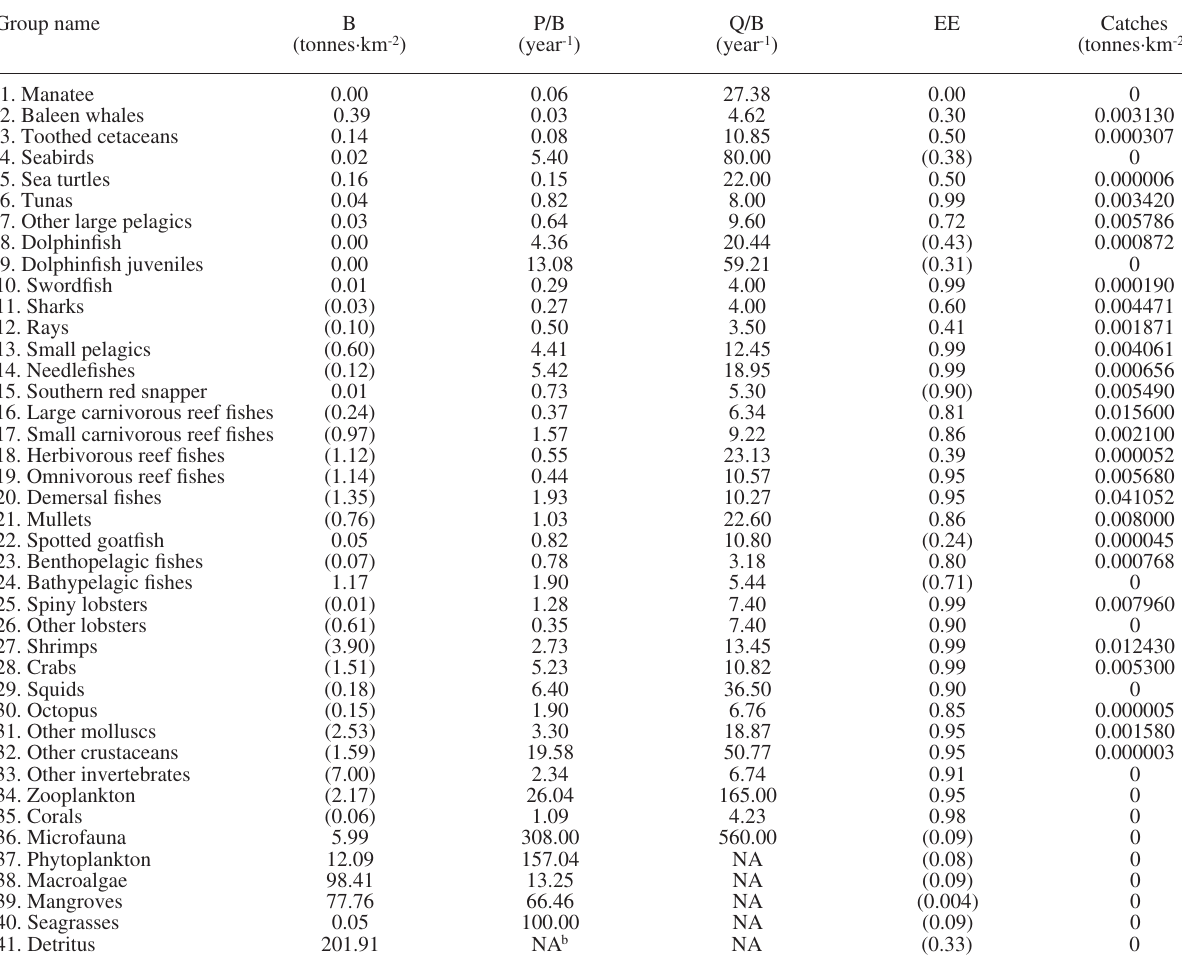
Table 1. – Basic input for the 1970s Ecopath with Ecosim model for the marine ecosystem off northeastern Brazil. B = biomass in the habi- tat area (wet weight); P/B = production/biomass; Q/B = consumption/biomass; and EE = ecotrophic efficiency a . Only significant digits are